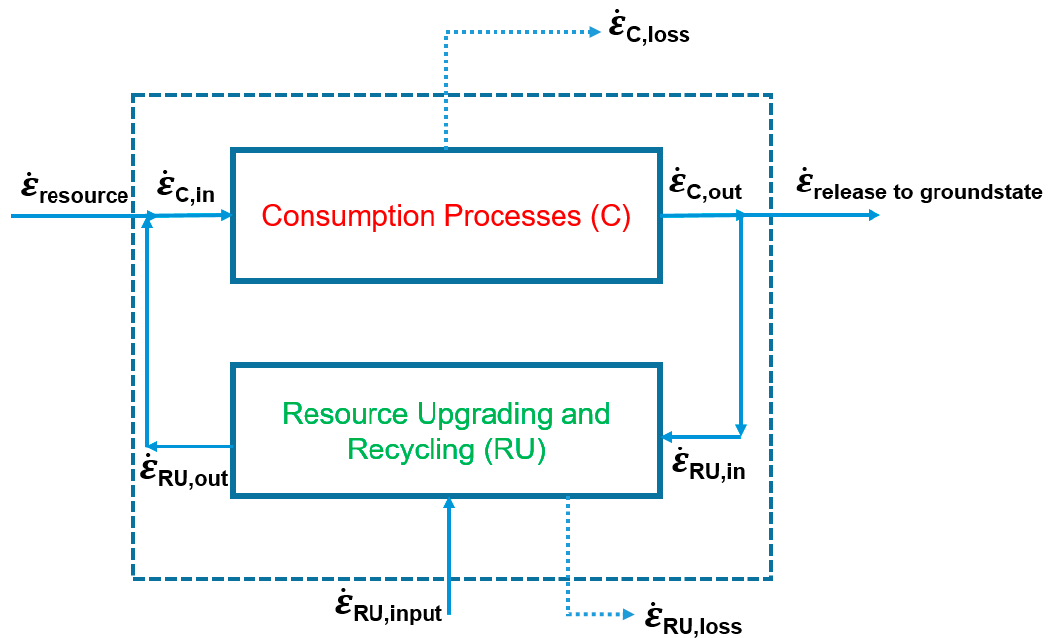
Figure 8. Proposed exergetic efficiency calculation boundary to access resource consumption and depletion, adapted from Connelly and Koshland [29].